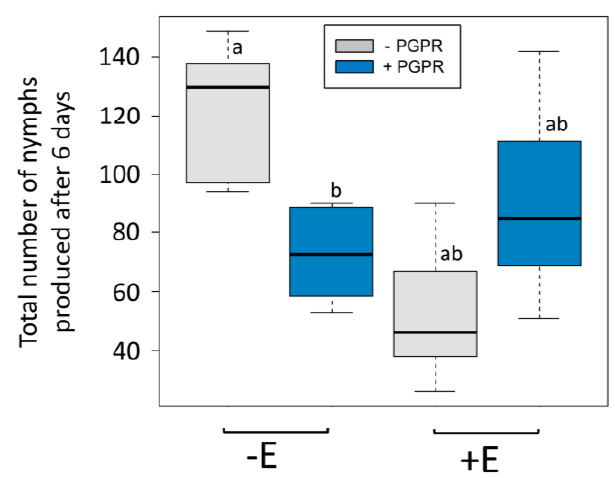
Figure 1. Boxplots of the numbers of nymphs produced 6 days after infestation with five A. pisum aphids − E and + E (absence and presence of endosymbiont Hamiltonella defensa , respectively), on plants inoculated or not inoculated with Bacillus amyloliquefaciens ( + plant growth-promoting rhizobacteria (PGPR) and − PGPR, respectively). The di ff erent letters indicate significant di ff erences between groups (Tukey’s honestly significant di ff erence (HSD) p < 0.05, n = 9).